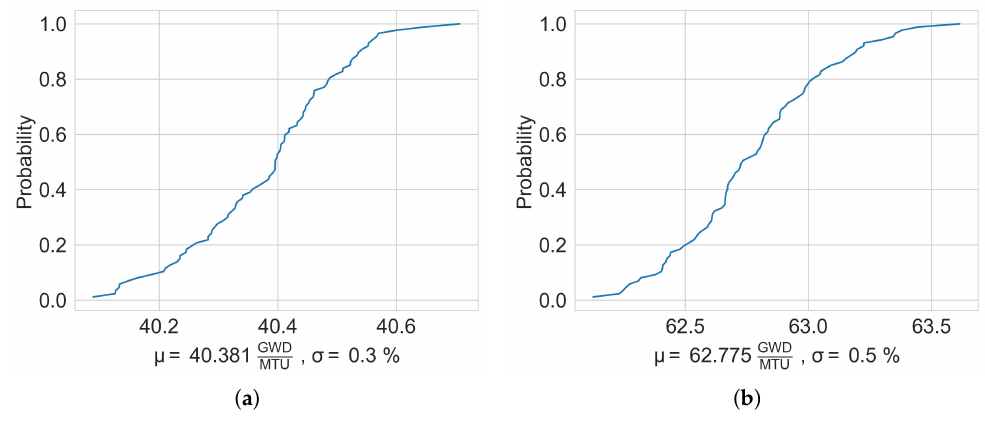
Figure 37. ECDF of ( a ) Bu ave and ( b ) Bu max